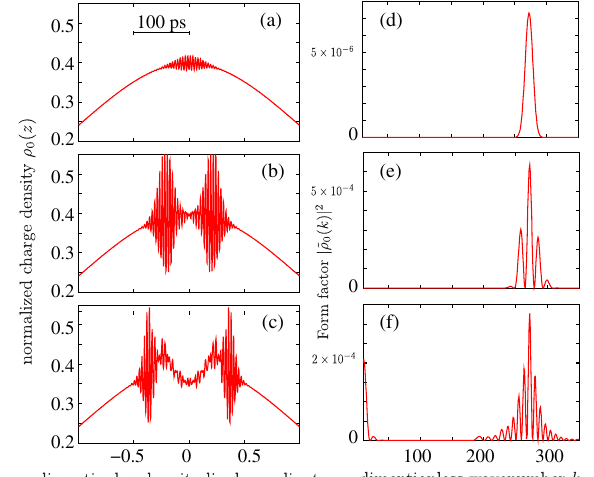
FIG. 7. Local saturation process visible on the normalized charge density profile (cid:2) 0 ð z Þ of the electron bunch. Numerical calculations were made using w 0 ¼ 1 (a), w 0 ¼ 10 (b), and ¼ 50 (c). Panels (d), (e), and (f) show the form factors w 0 (i.e., power spectra) associated to (a), (b), and (c), respectively. Dimensionless laser pulse duration is (cid:4) L ¼ 0 : 117 (i.e., 28.5 ps). Other parameters are the same as for Fig.